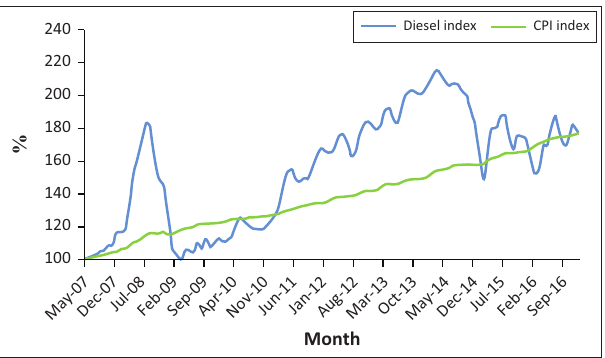
TABLE 1: Rate card cost drivers. Component